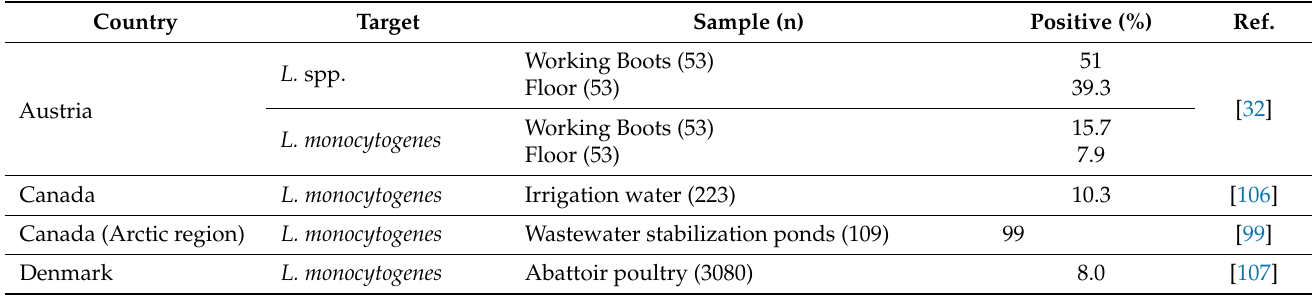
Table 4. Listeria spp. isolated from the farm and